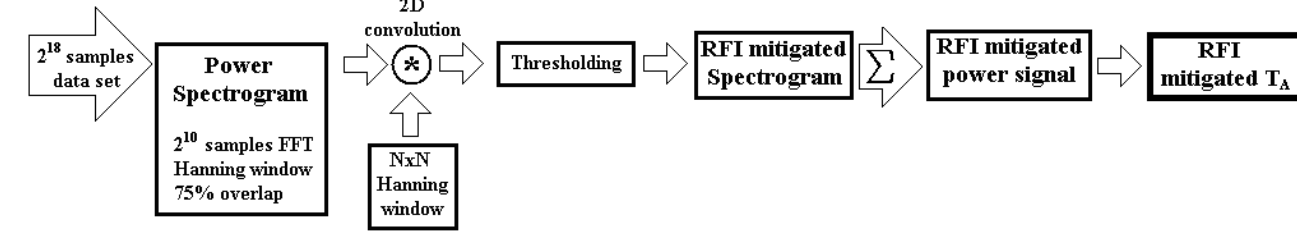
Figure 3. Smoothing algorithm